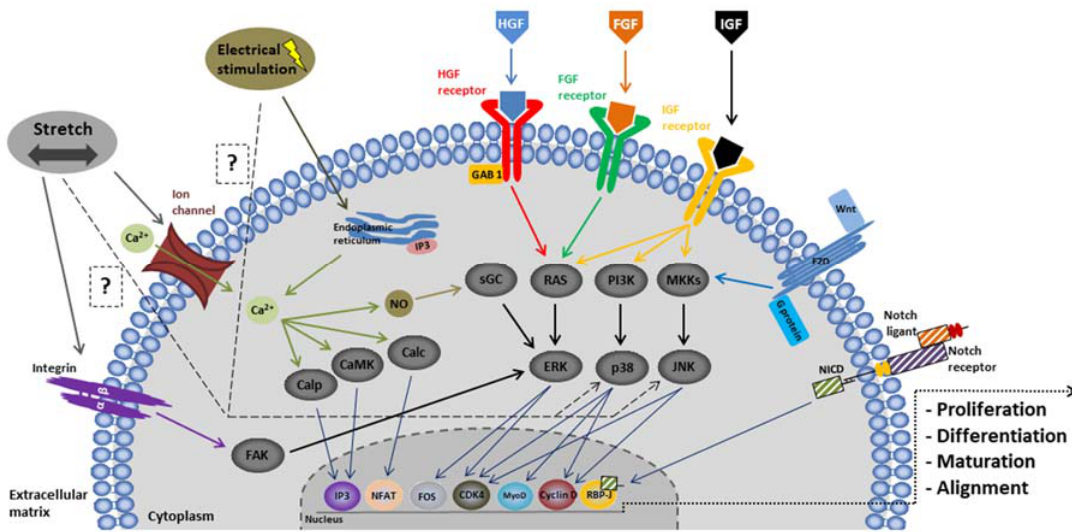
Figure 5. Schematic representation of skeletal muscle cell mechanotransduction: chemical signals are initiated by growth factors such as insulin-like growth factor (IGF), Hepatocyte growth factor (HGF), and fibroblast growth factor (FGF) binding to their respective receptors to trigger RAS, phosphatidylinositol-3-kinase (PI3K), and McKusick-Kaufman syndrome (MKKs) signaling cascades and activate Extracellular signal-regulated kinases (ERK), mitogen-activated protein kinases (p38), and c-Jun NH2-terminal kinases (JNK) pathways, respectively [233–235]. Electrical stimulation induces calcium release from the endoplasmic reticulum [236]. Calcium can act by activating either ERK [237] or calp, camk and calc [238–240]. Mechanical stretching signals involve the transmembrane protein integrin and the calcium ion channel [241]. Activating integrin triggers the FAK signaling pathway. Electrical and mechanical stimulations are also likely to activate the JNK and p38 pathways. Other pathways may be involved, such as wnt/frizzled and notch. All these signaling pathways up-regulate the expression of some of the genes responsible for skeletal muscle progenitor